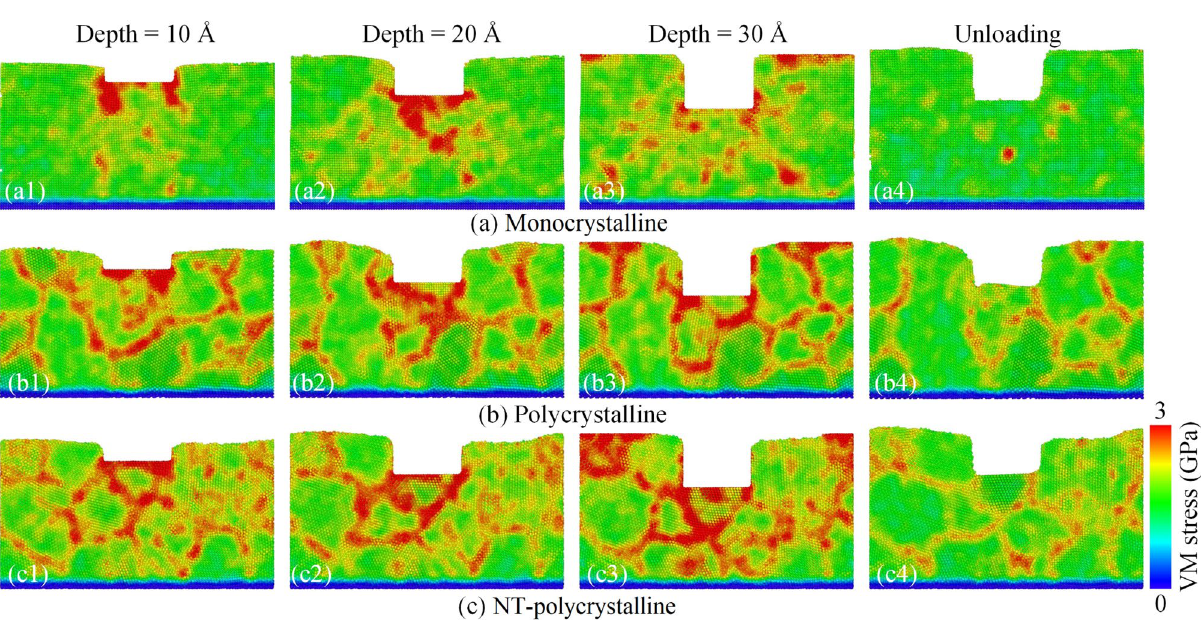
Figure 4. The cross-section of local stress dispersions of atoms at the various imprinting depths and unloading stage of the Al0.5 HEA for various crystal structures: monocrystalline ( a ); polycrystalline ( b ); and NT-polycrystalline ( c